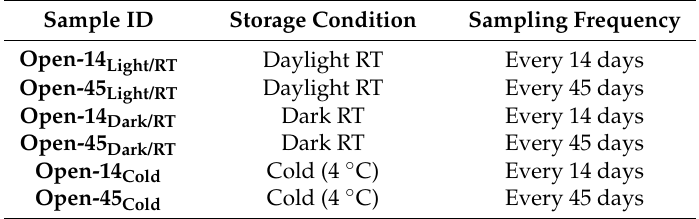
Table 1. Sample storage conditions and